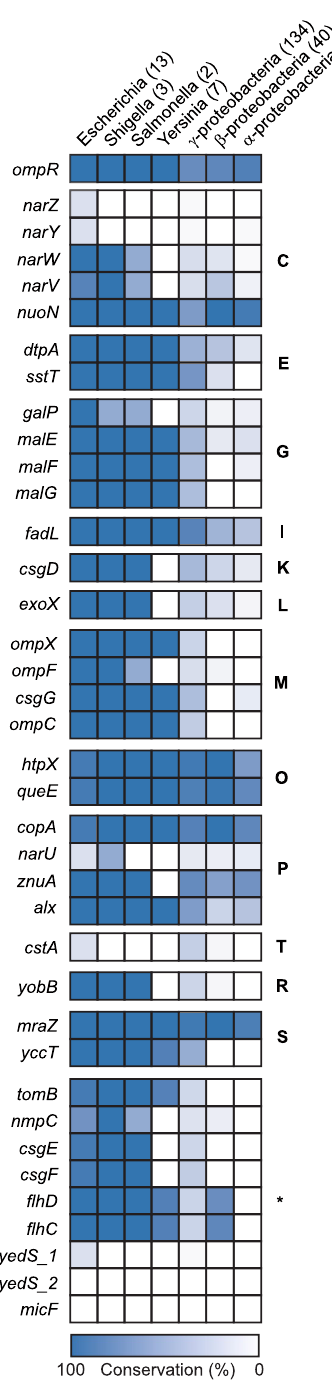
Figure 5. Evolutionary perspective on OmpR regulon. Conservation levels of the OmpR and its regulon genes across Escherichia, Shigella, Salmonella, Yersinia, γ -, β -, and α -proteobacteria are illustrated by the ortholog calculation. The genes were divided into 13 groups by their functions as in Fig.